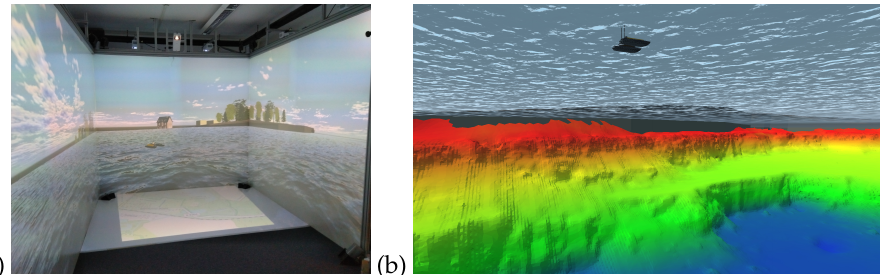
Figure 20. Exemplary scene in ( a ) Freiberg X-SITE CAVE to visualize field trials using historic data of the runs embedded in 3D scenes ( b ).